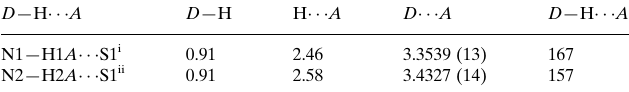
Hydrogen-bond geometry (A˚ , (cid:2)